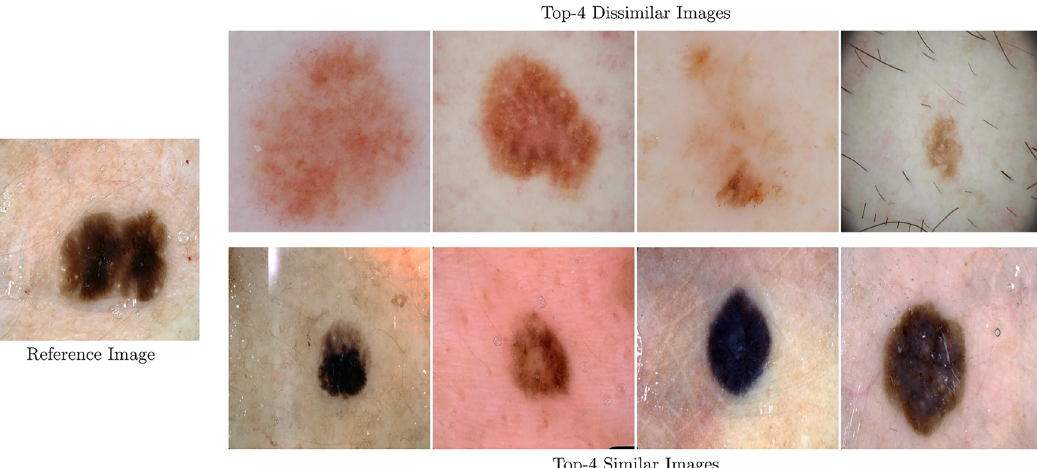
Figure 6: Visual validation heterogeneity sampling. Exemplary results of the heterogeneity sampler are presented. Considering a reference image of the ISIC 2017 Melanoma image segmentation dataset [16], the top-4 similar and top-4 dissimilar images are opposed. It is visible that the sampler is capable of distinguishing similar and dissimilar images using a pre-trained ResNet [21] decoder for feature extraction.